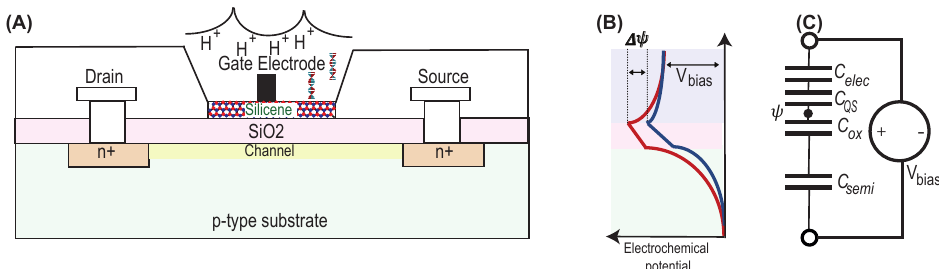
Figure 1. Design principle: ( A ) A simplified model of ISFET with silicene and the electrolyte, ( B ) electropotential curve of ISFET, and ( C ) equivalent capacitor